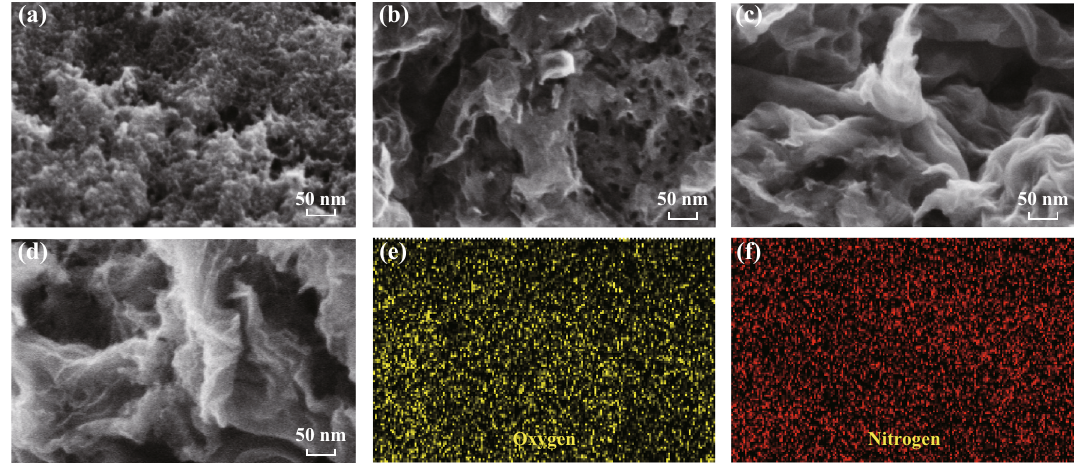
Fig. 1 SEM images of a PC, b NC-1, c NC-3, d NC-6, and the corresponding elemental e O and f N mapping images of